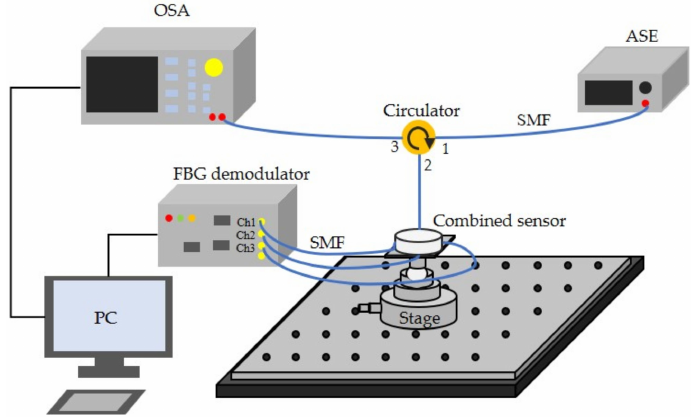
Figure 6. Experimental setup for the attitude measurement